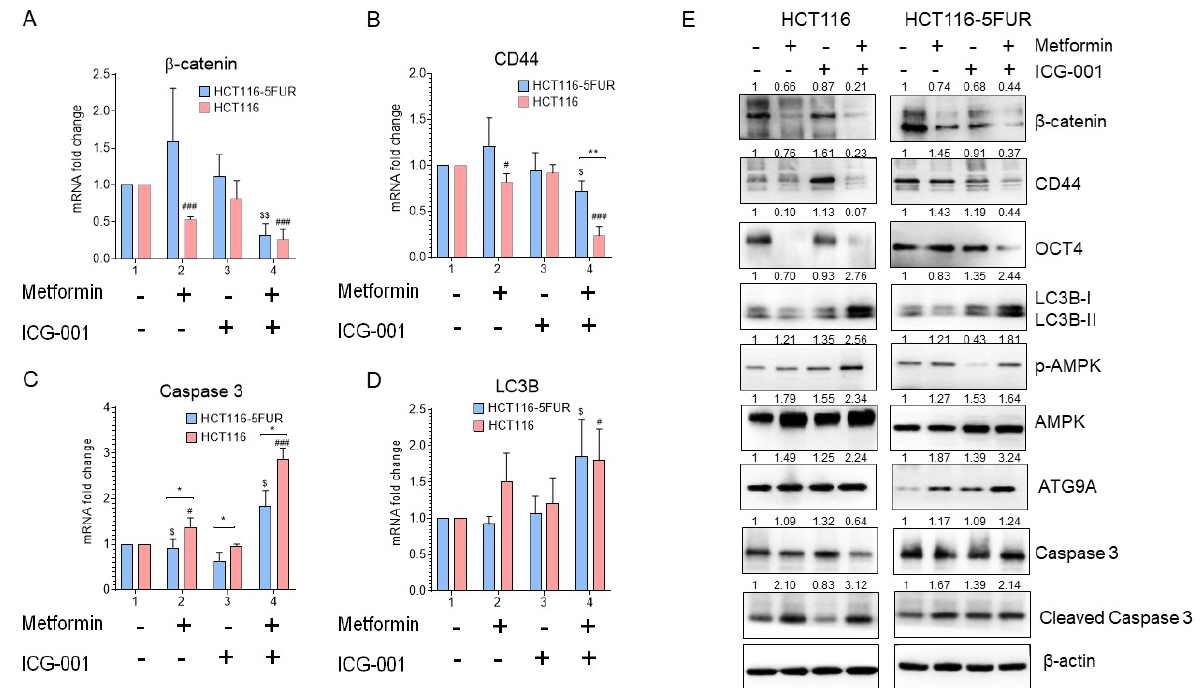
Figure 5. Gene and protein expression profiling after treatment with metformin and ICG-001, either alone or in combination, in parental and 5FUR CRC cells. Gene expression of ( A ) β -catenin, ( B ) CD44, ( C ) caspase 3 and ( D ) LC3B after treatment with metformin and ICG-001, either alone or in combination, for 48 h. β -actin was used as a housekeeping gene. ( E ) WB analysis of β -catenin, CSC markers (CD44 and OCT4), apoptosis markers (caspase 3 and cleaved caspase 3), autophagy markers (LC3B, ATG9A), and phosphorylation status of AMPK after treatment with metformin and ICG-001, either alone or in combination, for 48 h. β -actin was used as loading control for WB analysis. Original blots see Figure S2. Statistical significance was determined by a Student’s t -test. (Comparison between Parental vs. 5FUR-* p < 0.05, ** p < 0.01; Comparison between Control and treatment groups for HCT116- $ p < 0.05, $$ p < 0.01; Comparison between Control and treatment groups for HCT116-5FUR- # p < 0.05, ### p <